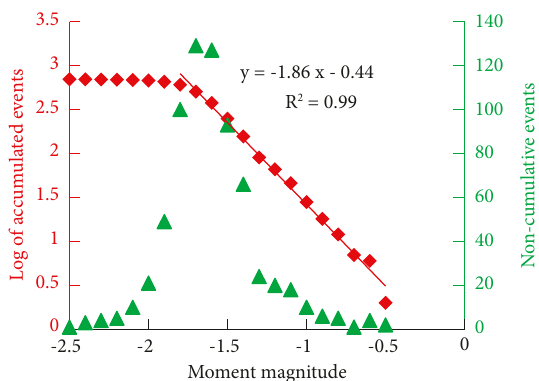
Figure 19: Moment magnitude-frequency curve of the tailrace tunnel.